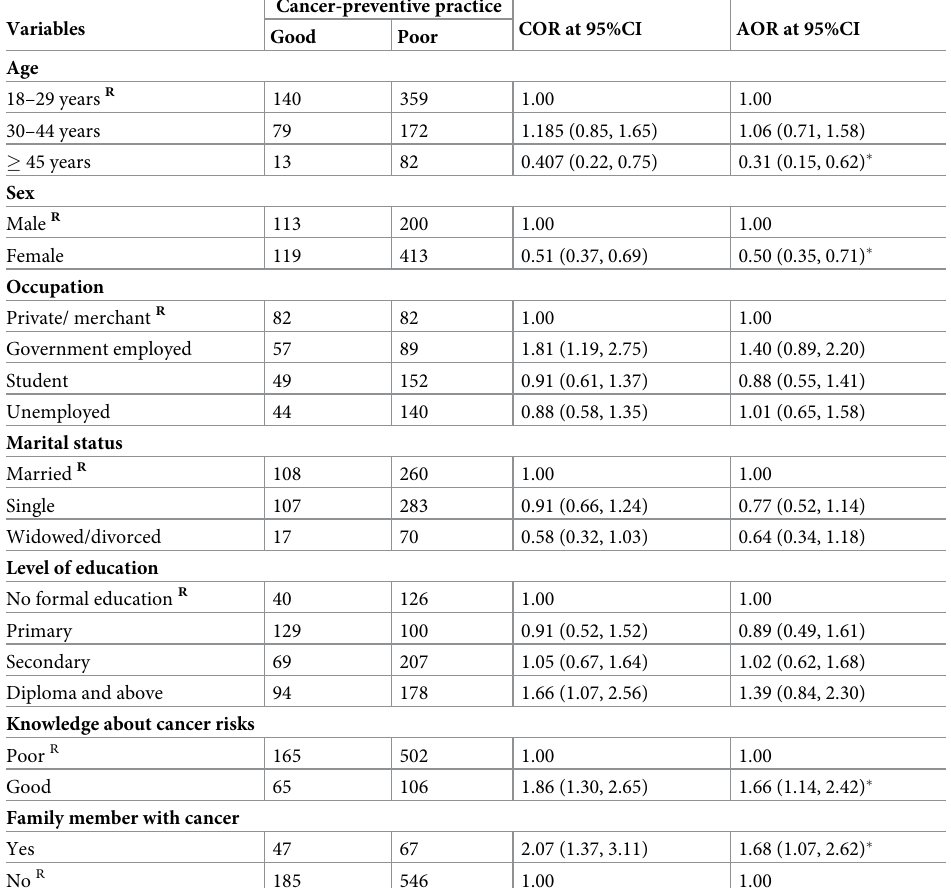
Table 5. Simple logistic regression analysis on factors associated with cancer preventive practice of the respon- dents, Bahir Dar city residents, Northwest Ethiopia, 2019 (n = 845).